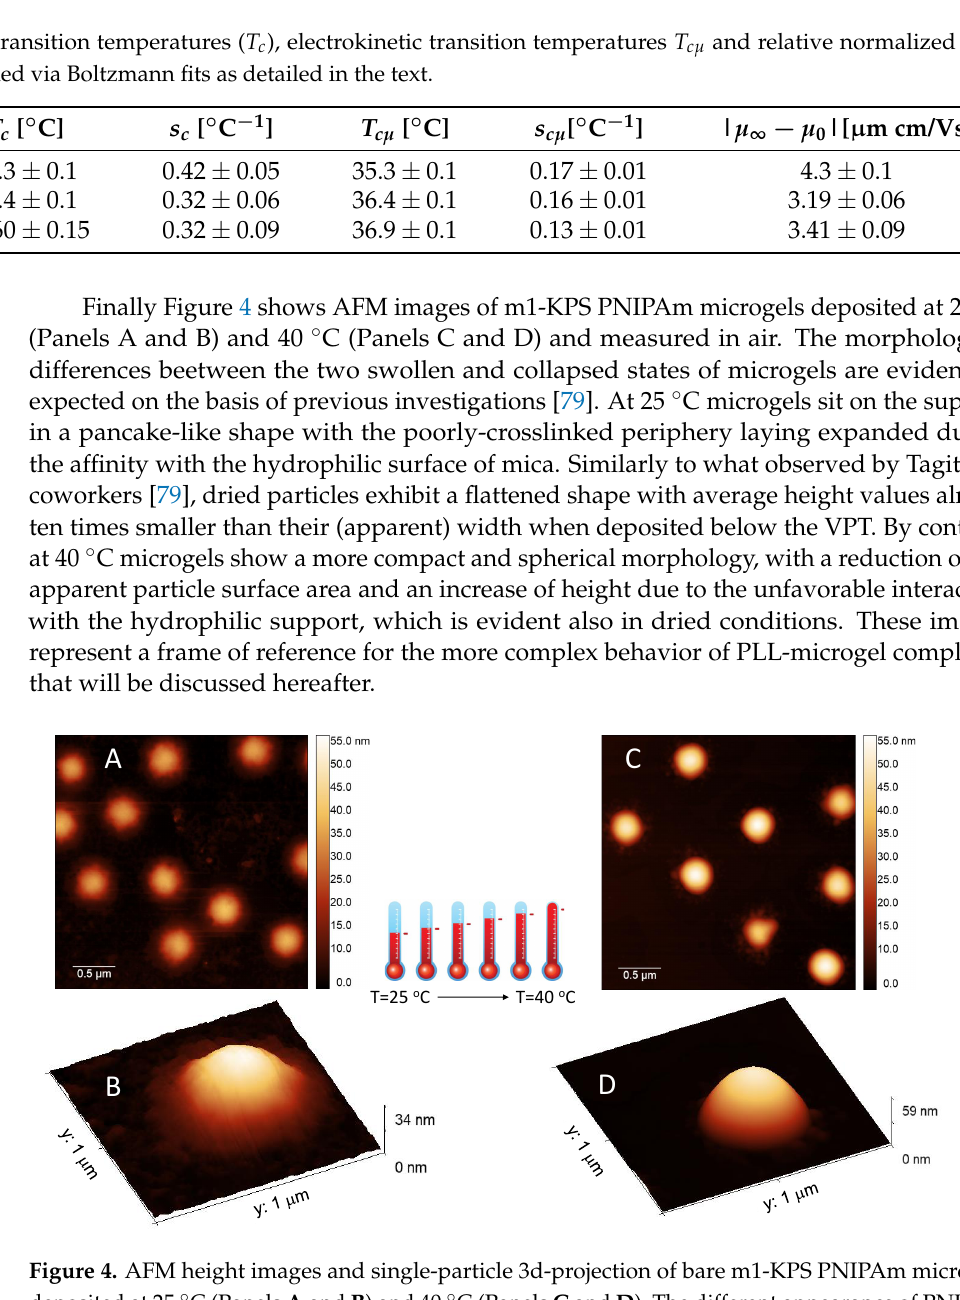
Figure 4. AFM height images and single-particle 3d-projection of bare m1-KPS PNIPAm microgels deposited at 25 ◦ C (Panels A and B ) and 40 ◦ C (Panels C and D ). The different appearance of PNIPAm particles is determined by the variation of the hydrophilic character of the polymer network, which influences the interaction with the hydrophilic mica substrate. At T = 40 ◦ C microgel particles become less affine to the substrate, with respect to room temperature, so dried particles result more compact and